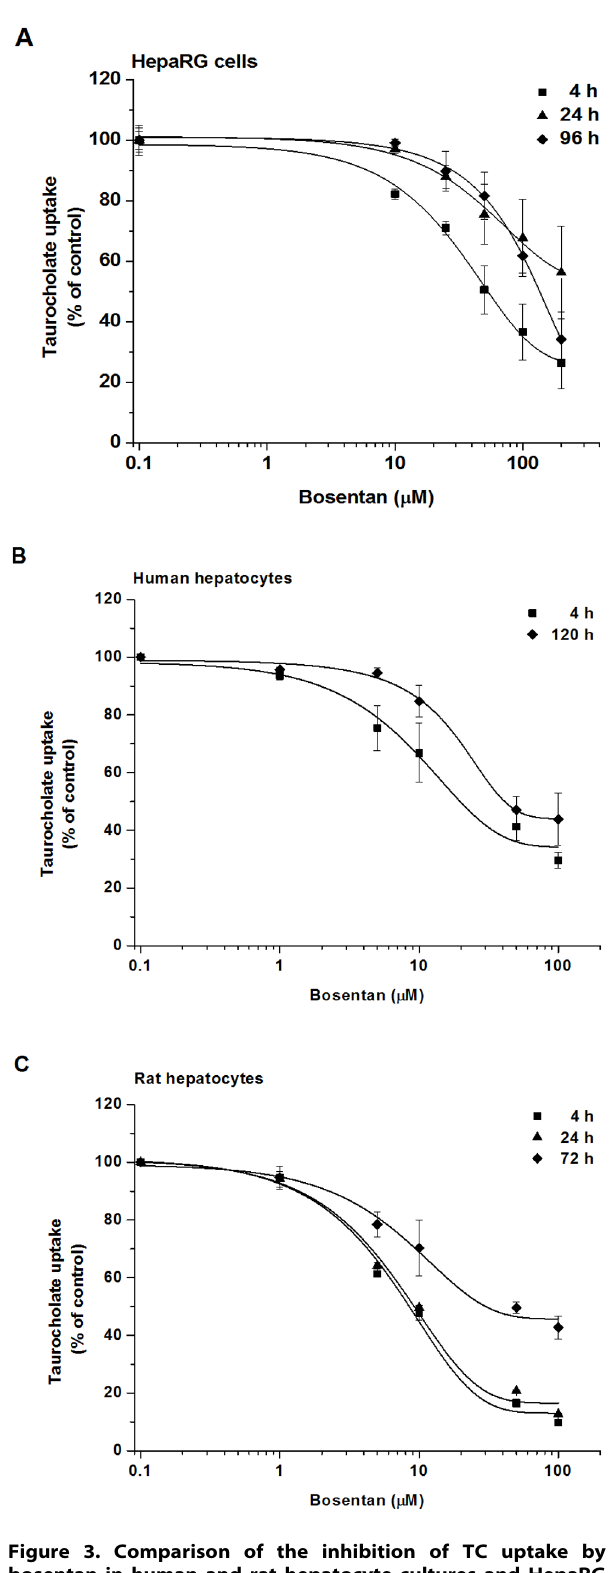
Figure 3. Comparison of the inhibition of TC uptake by bosentan in human and rat hepatocyte cultures and HepaRG cell cultures. (A) HepaRG cells were treated with 1 m M of 3 H-TC for 300 sec at 4, 24 and 96 h after seeding in the presence of bosentan (10– 200 m M), or the vehicle, respectively. (B) Human and (C) rat hepatocytes were treated with 1 m M of 3 H-TC for 30 sec at 4, 24 and 72 h (rat) or 4, 120 h (human) after seeding in the presence of bosentan (10–100 m